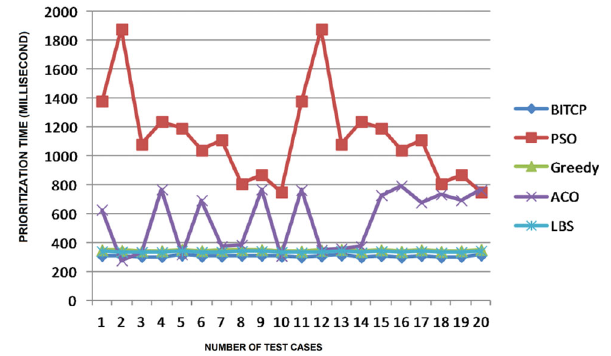
Fig. 13 Prioritization performances of all algorithms in terms of time. The most unstable algorithm is PSO that its performance does not depend the number of iteration in which the iteration range is 8–13. LBS, Greedy, and BITCP seem to have the best results with regard to the stability